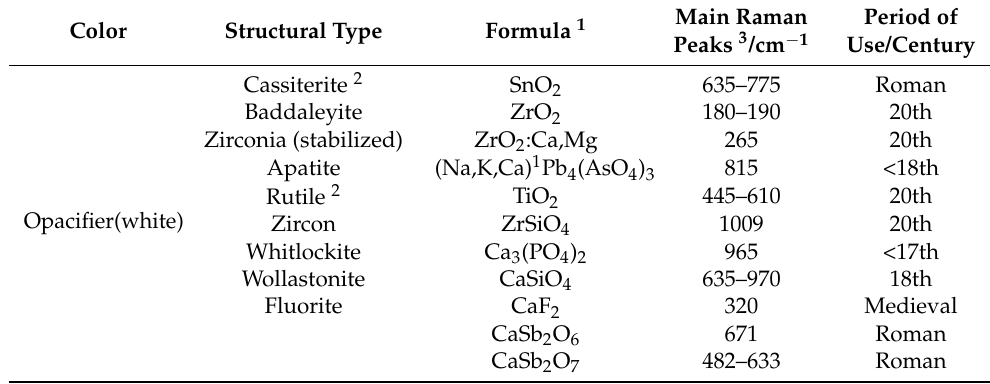
Table 2. Structure, formula, main characteristic Raman peak(s) or doublet wavenumber of crystalline pigments; period of use is